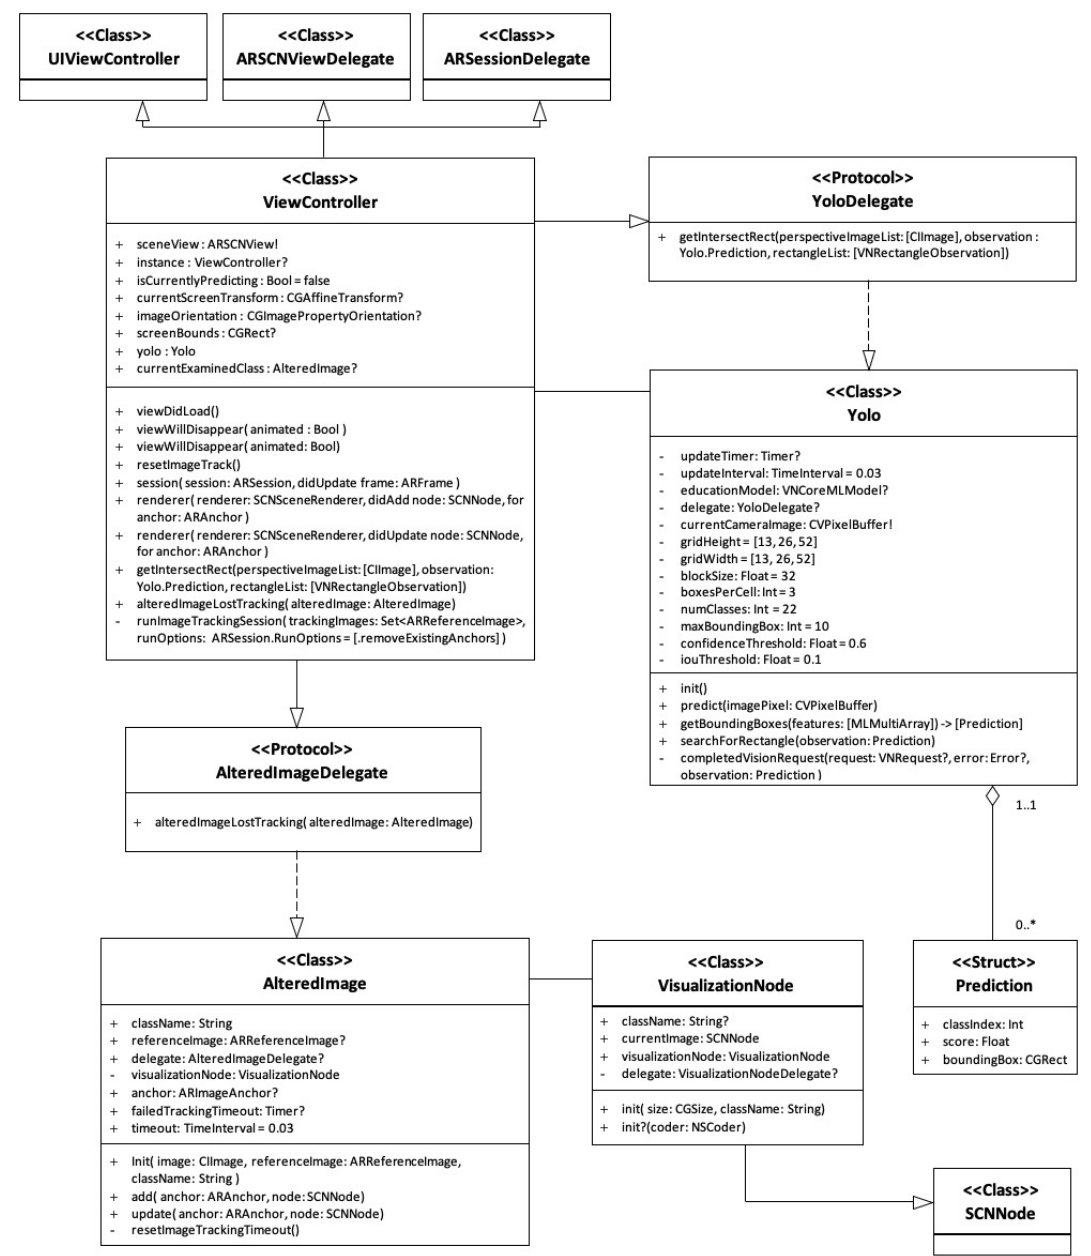
Figure 14. The class diagram of the iOS